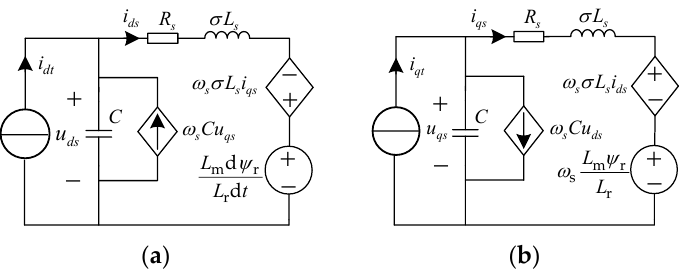
Figure 7. Second order equivalent circuit of the IM and AC − filter capacitor in the d − q axis: ( a ) d − axis; ( b ) q − axis.